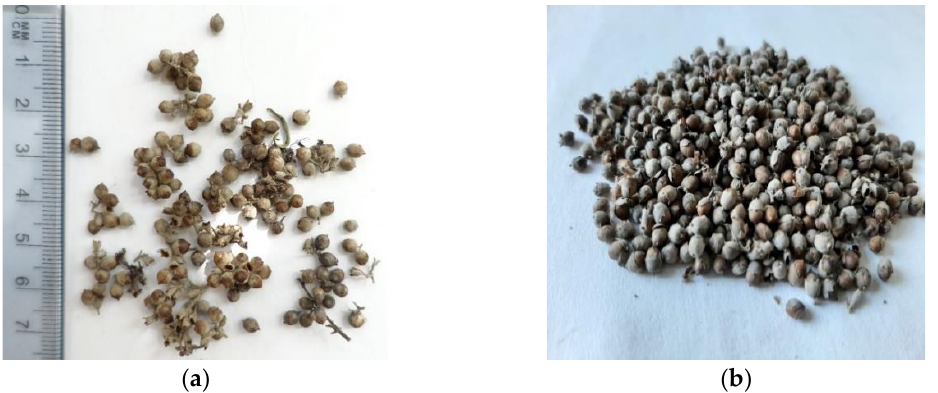
Figure 1. Fruits from V. agnus-castus L. (authors’ images). ( a ) Fruits from south-central region of Bulgaria. ( b ) Fruits from north-east region of Bulgaria.